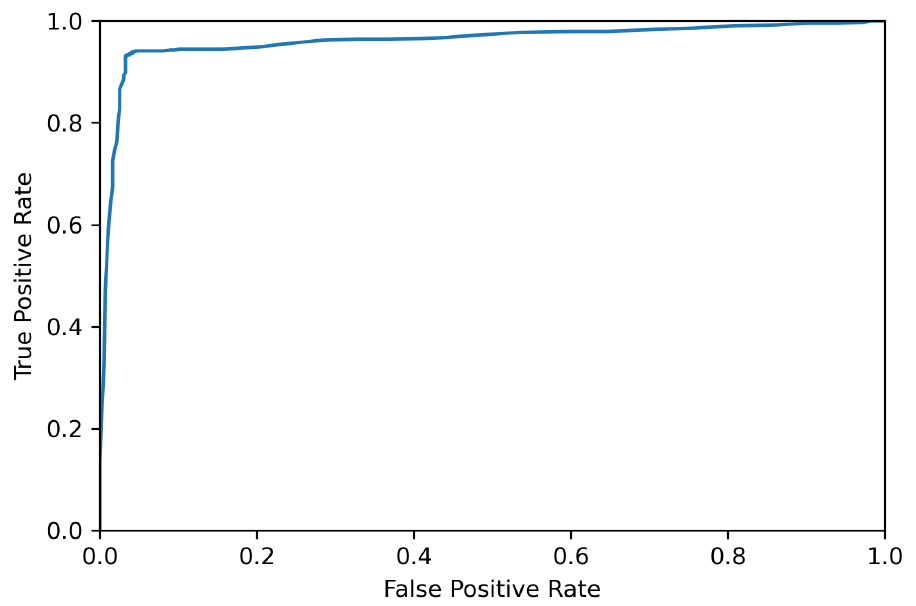
Figure 9. ROC curve of the results from the RF algorithm.